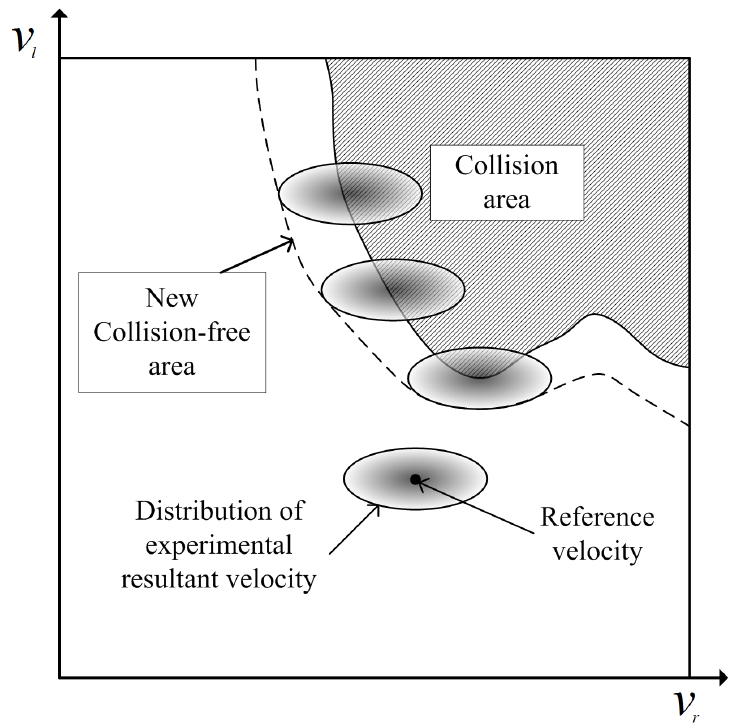
Figure 3. Uncertainty ellipse around the reference velocity in the input